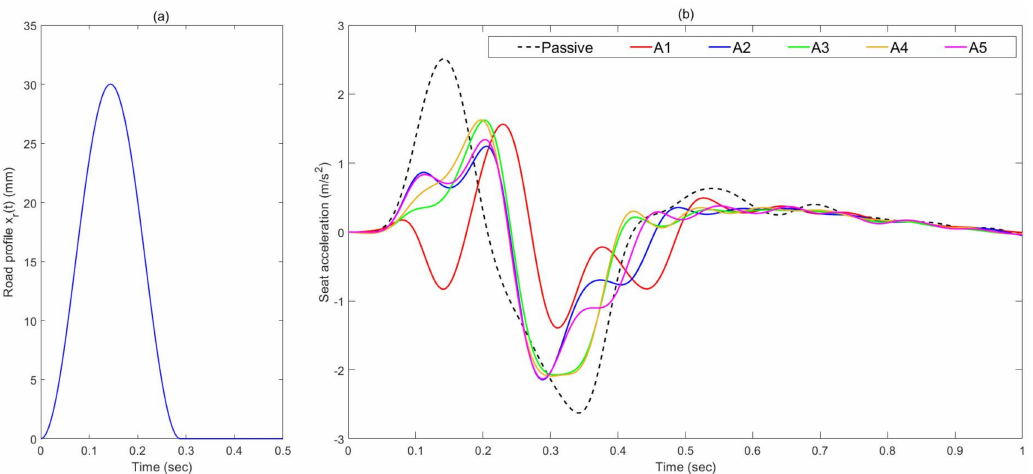
Figure 21. Bump road profile and measured seat acceleration of active system using different control strategies. ( a ) Road profile; ( b ) Seat acceleration.